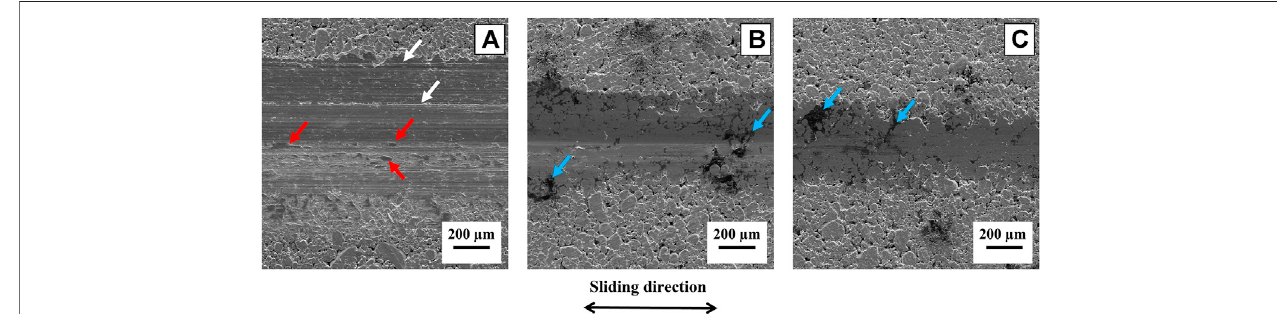
Frontiers in Mechanical Engineering |